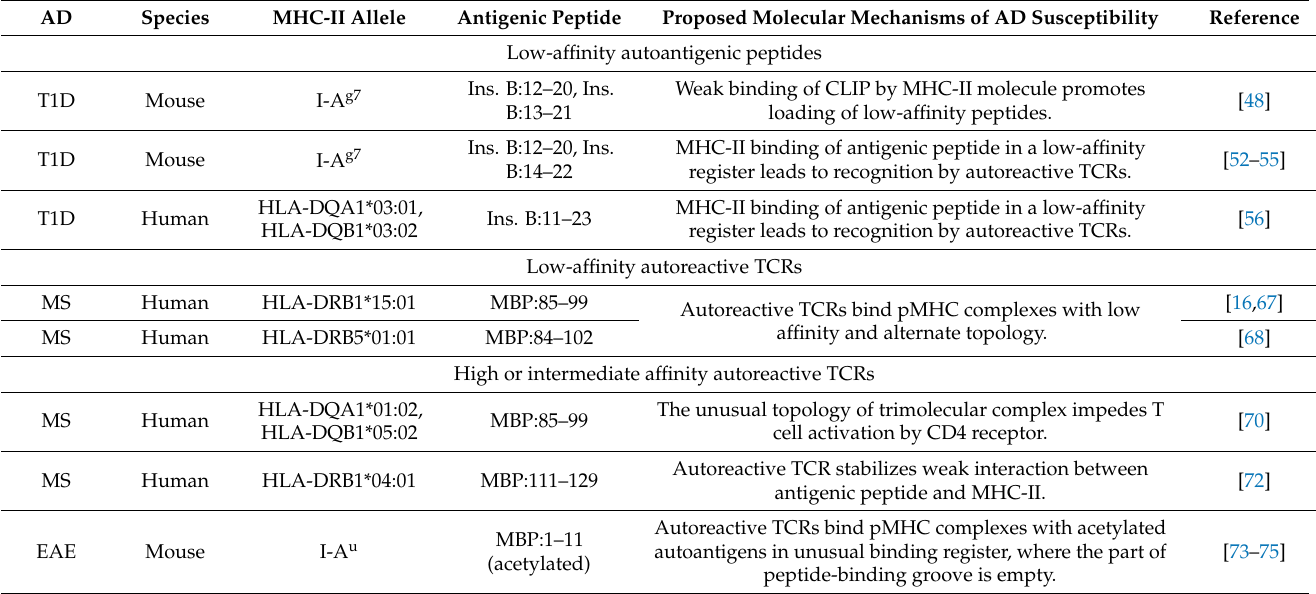
Table 1. Autoantigens and autoimmune TCRs in autoimmune